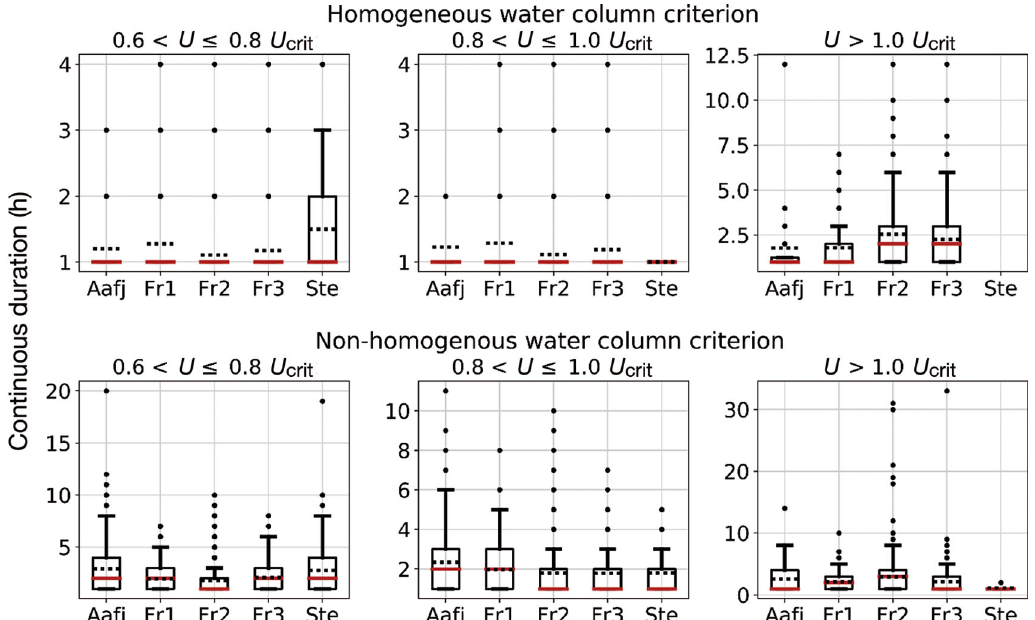
Fig. 9. Number of consecutive hours where the currents were within given ranges of the critical swimming speed ( U crit ) for lumpfish Cyclopterus lumpus using both the homogeneous and non-homogeneous criterion. Other details are the same as